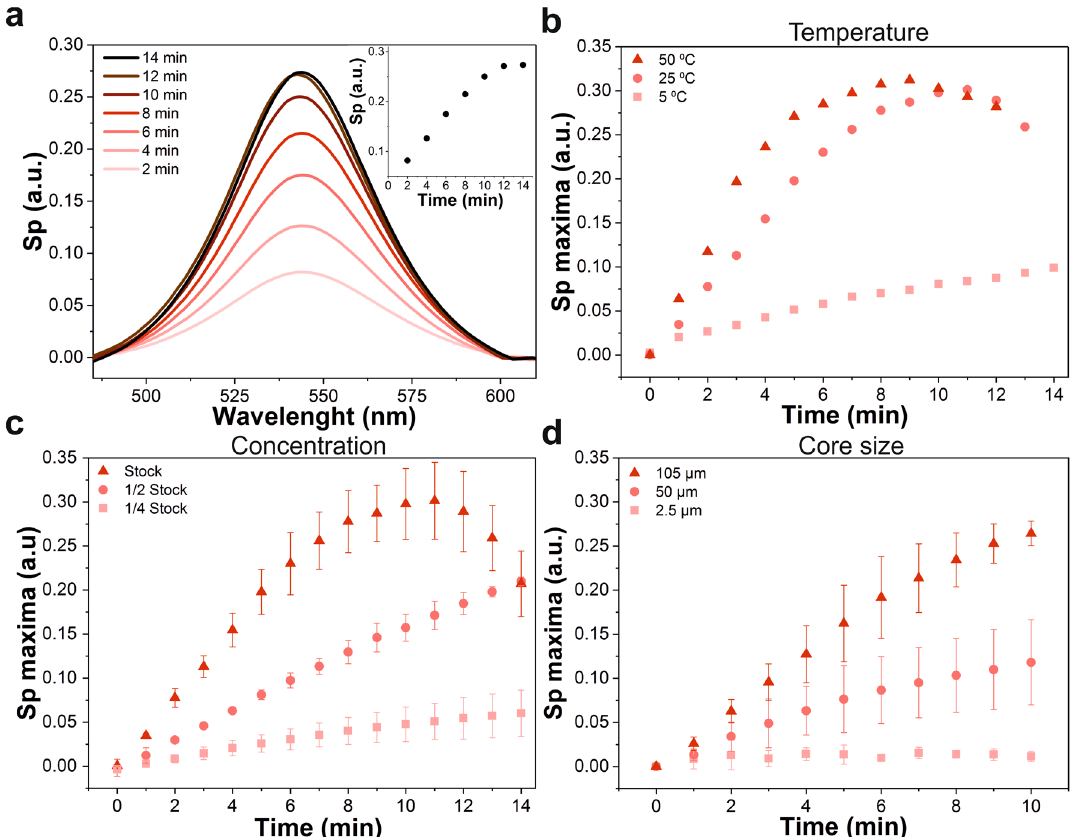
Figure 2. Effect of temperature, AuNPs concentration and optical fiber core size on the LSPR signal of OF-LSPR sensors. ( a ) Temporal evolution of the LSPR signal of one 105MMF immersed in stock concentration of AuNPs at room temperature (22 °C). ( b ) Sp maximum values for 105MMFs at different temperatures (5, 25, and 50 °C) measured every minute during 14 min after immersion in AuNPs. ( c ) Sp maximum values achieved at 22 °C and fiber core diameter of 105 μm, with different AuNPs concentrations, measured every minute during 14 min after immersion in AuNPs. ( d ) Sp maximum values for optical fibers with different core